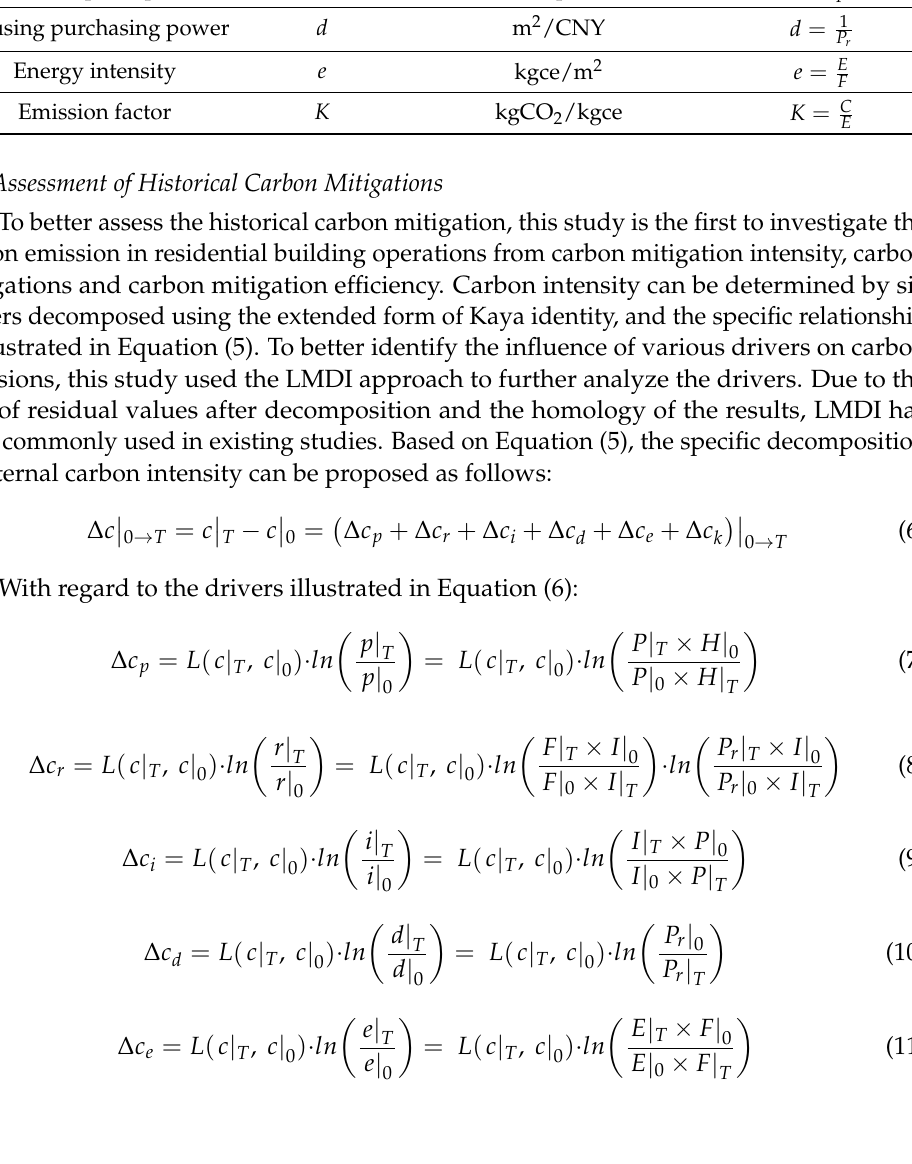
Table 1. Explanation of six carbon intensity drivers for residential building operations. Variables Symbol Unit Expression Mega tons of carbon dioxide - Carbon emissions C (MtCO 2 ) Mega tons of standard coal - Energy consumption E equivalent (Mtce) Gross floor space F Million square meters (m 2 ) - Household size H Household - Total income I Billion Chinese yuan (CNY) - Population Million persons Housing price Average household size Person/household Housing price to Income per capita Housing purchasing